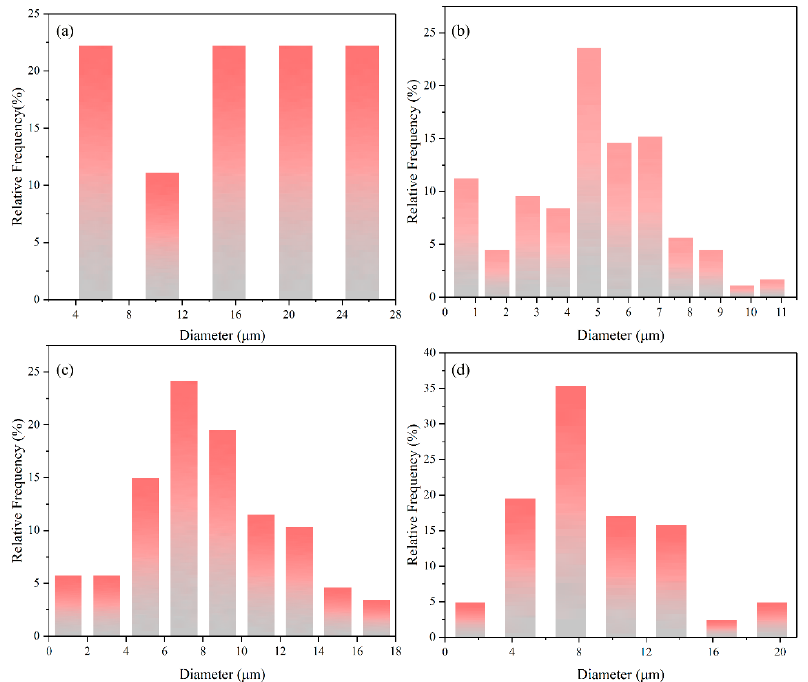
Figure 6. Grain size distribution of Mo 2 FeB 2 hard phases with different RE contents: ( a ) RE = 0%; ( b ) RE = 2%; ( c ) RE = 4% and ( d ) RE = 8%.